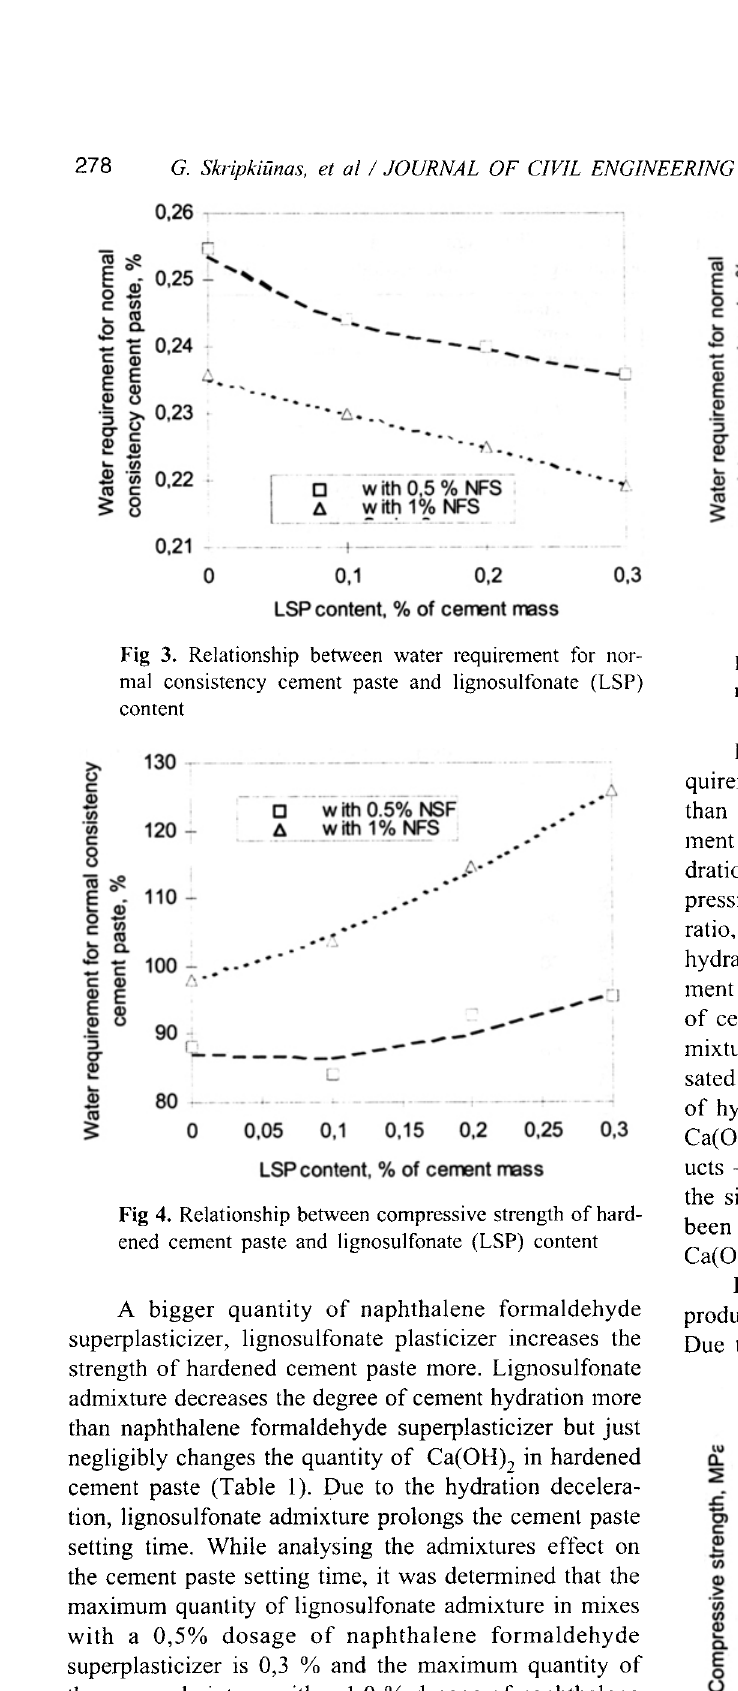
Fig 6. Relationship between hardened cement paste com pressive strength and silica fume